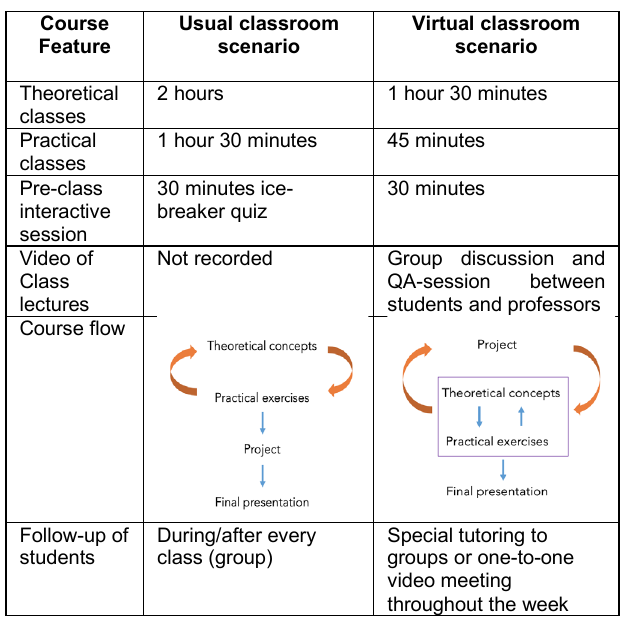
Table 3. Adaptation of the new teaching paradigms adapted to virtual learning